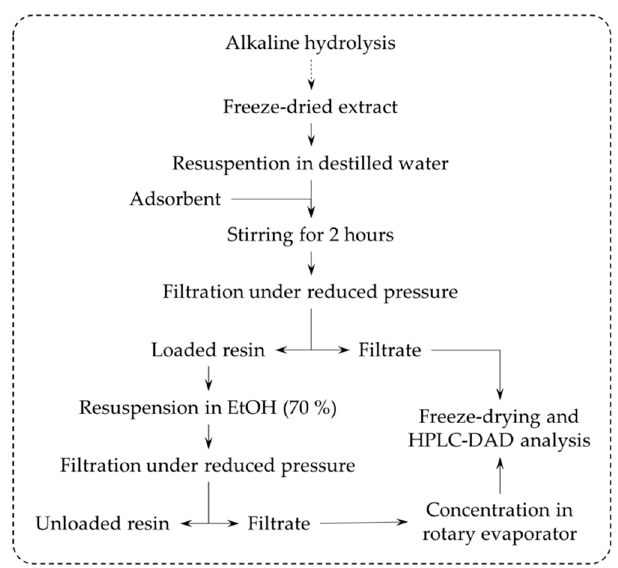
Figure 2. Procedure for the partial purification of FA by adsorption on a synthetic resin.